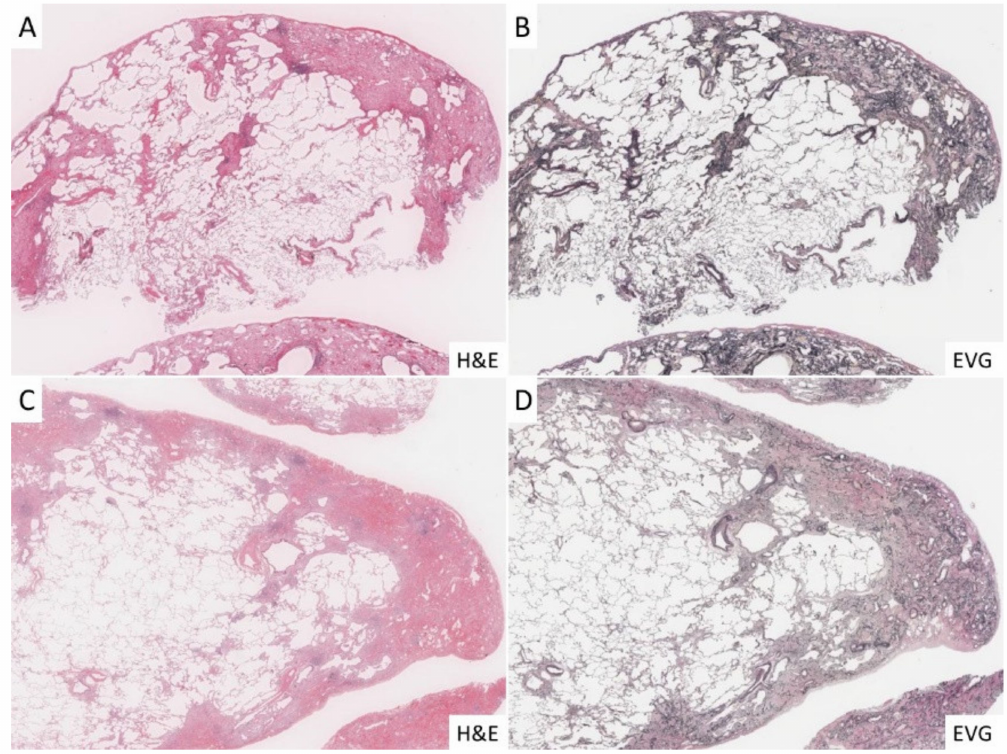
Figure 2. Histopathological findings in the cases investigated for the current study. ( A , B ): In the PPFE group, fibroelastosis was significant under the pleura, and there was marked increase in elastic fibers with EVG staining. ( C , D ): In the IPF group, the development of dense fibrosis and fibroblastic foci was significant in subpleural and interlobular septa, and lung architecture destruction was highlighted with EVG